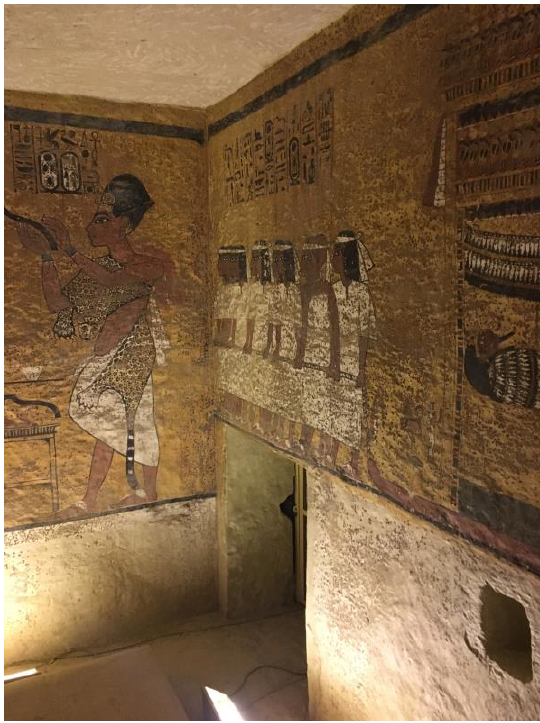
Figure 5. The northeast corner of the burial chamber of the tomb of Tutankhamen, Valley of the Kings © J. Paul Getty Trust 2015